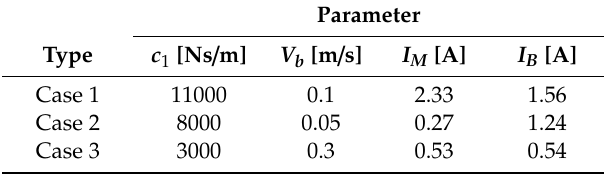
Figure 15. Piecewise bilinear damping characteristic. Table 3. Required input current 𝐼 𝑀 and 𝐼 𝐵 for implementing some desired 𝑐 1 and 𝑉 𝑏 . Table 3. Required input current I M and I B for implementing some desired c 1 and V b .